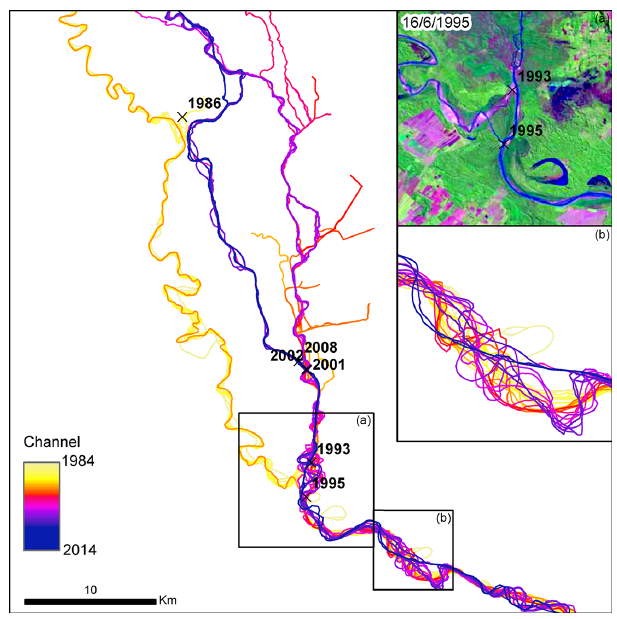
Figure 10. Avulsions and crevasses of the Río Grande. Inset (b) shows that the Río Grande has a multithreaded channel until it reaches the point of the 1995